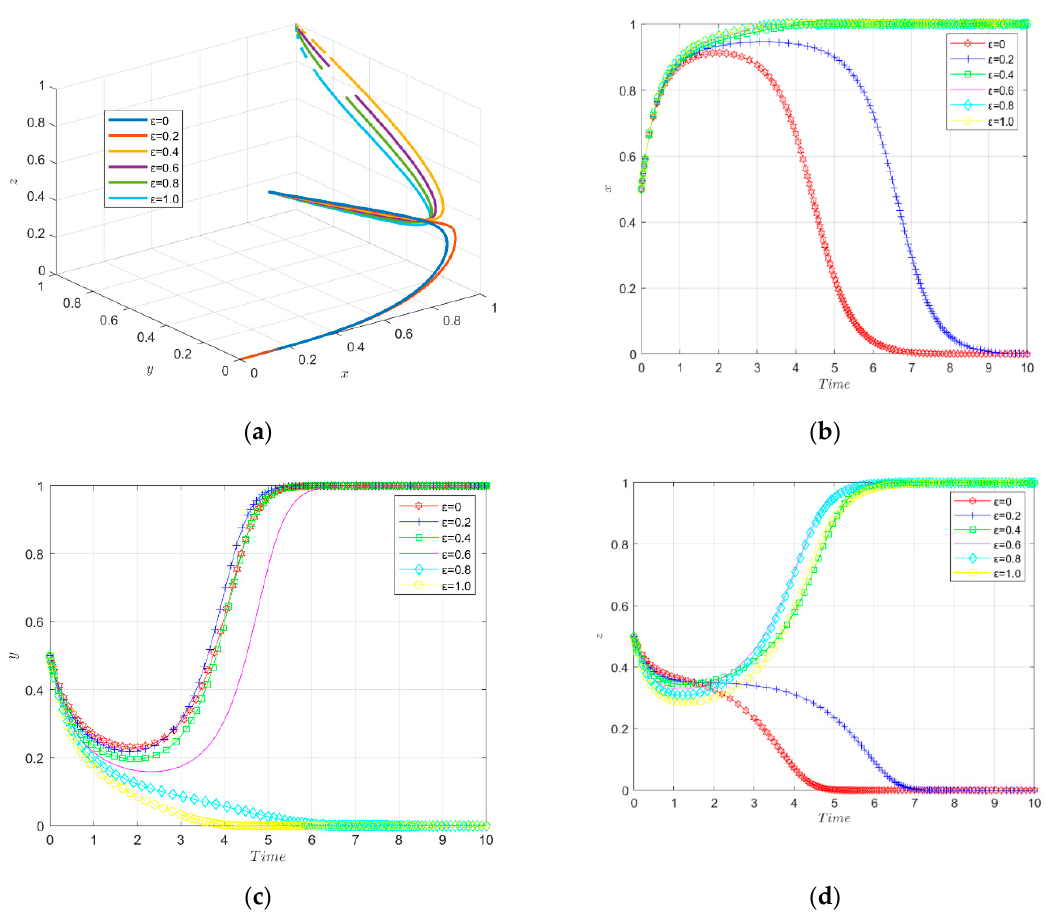
Figure 10. ( a ) Evolutionary trajectory of the tripartite game under different financial subsidies in- tensities. Evolutionary trajectories of enterprises ( b ), government ( c ) and financial institutions ( d ) under different financial subsidies intensities.